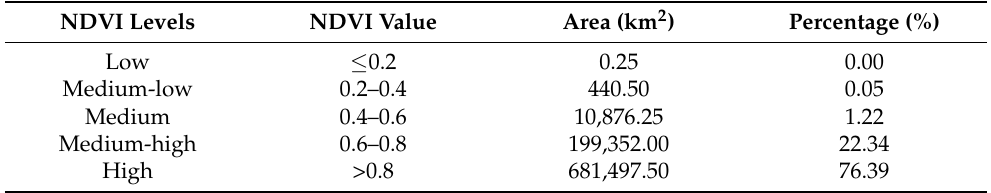
Table 3. Area and proportion of different levels of multi-year annual mean NDVI in the QBM (2003–2018).